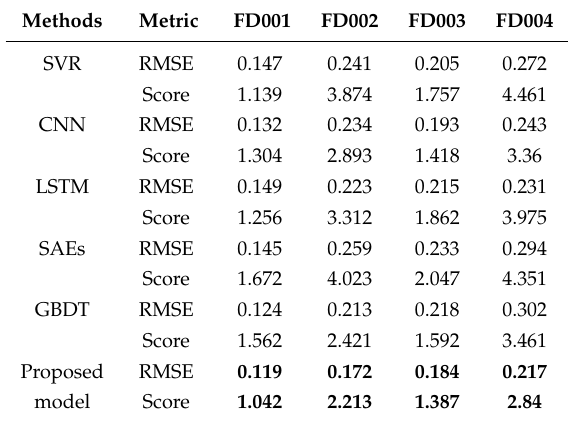
Table 3. The evaluation metrics values of each dataset based on different